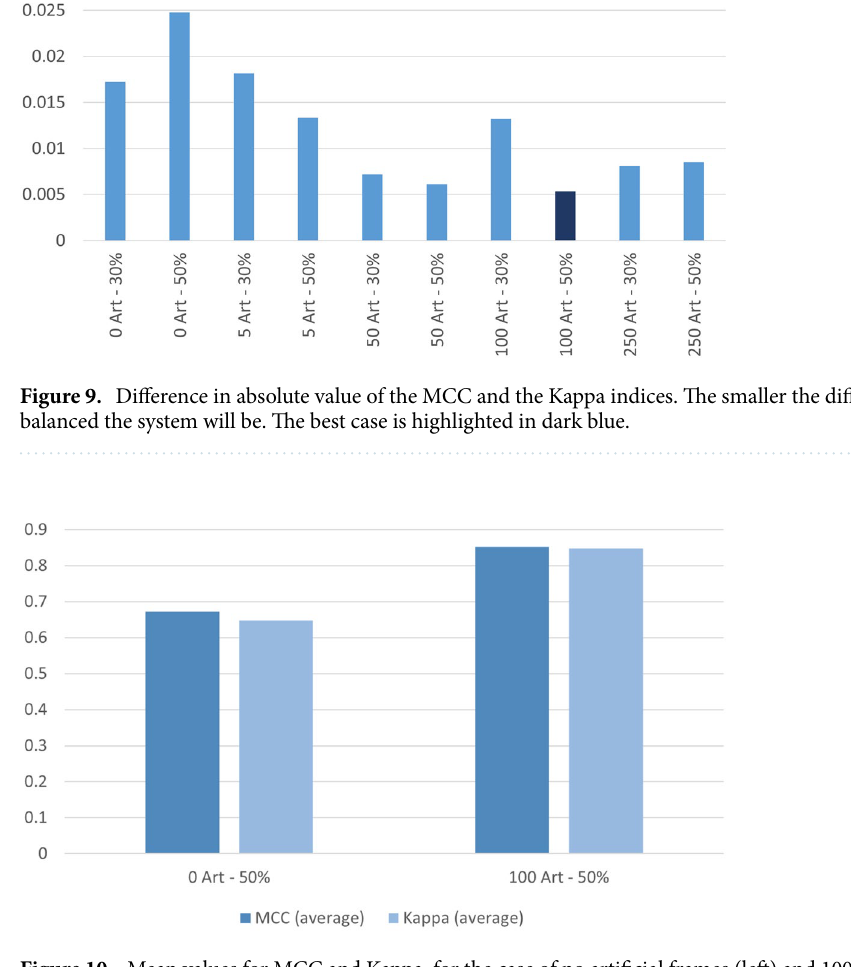
Figure 10. Mean values for MCC and Kappa, for the case of no artificial frames (left) and 100 artificial frames per group (right). In both cases, 50% of the real data is used for